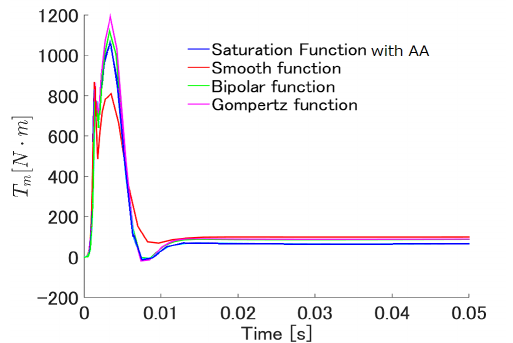
Figure 20. Enlarged view of time response of driving torque on icy road (( 0 < t < 0 : 05 )